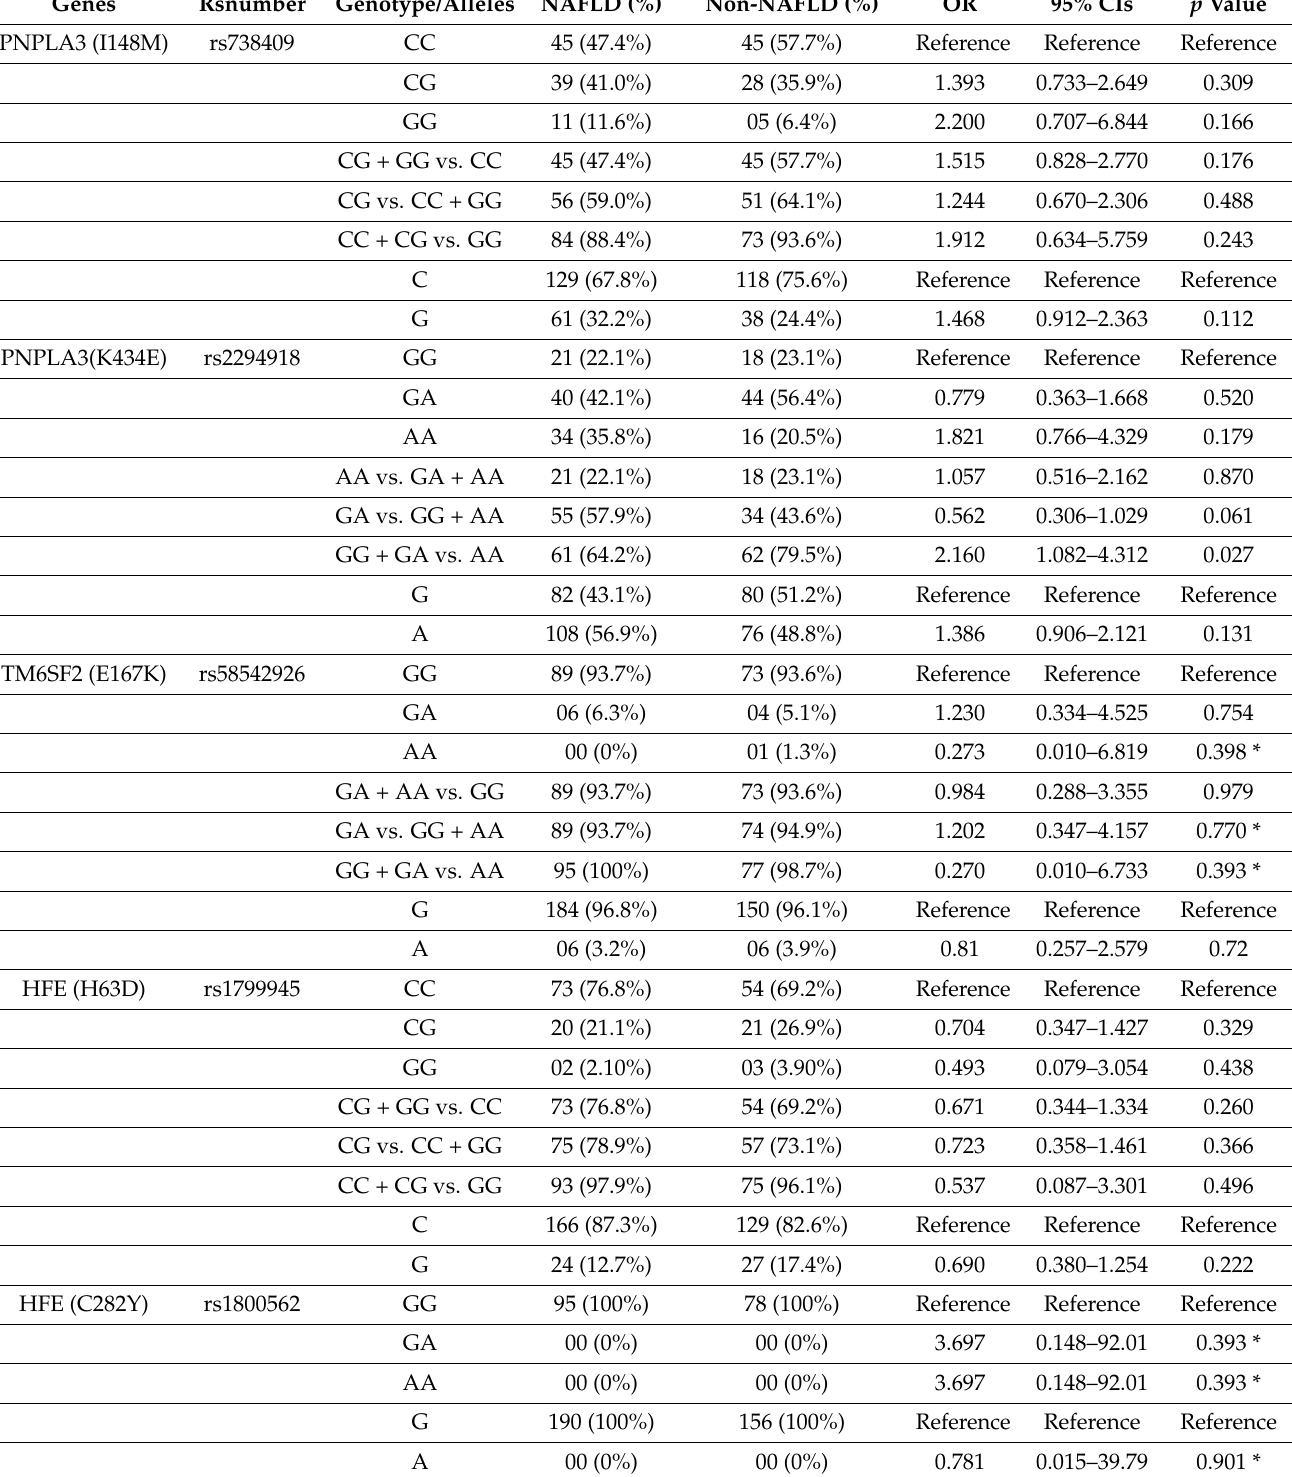
Table 3. Genotype and allele distribution in the NAFLD and non-NAFLD